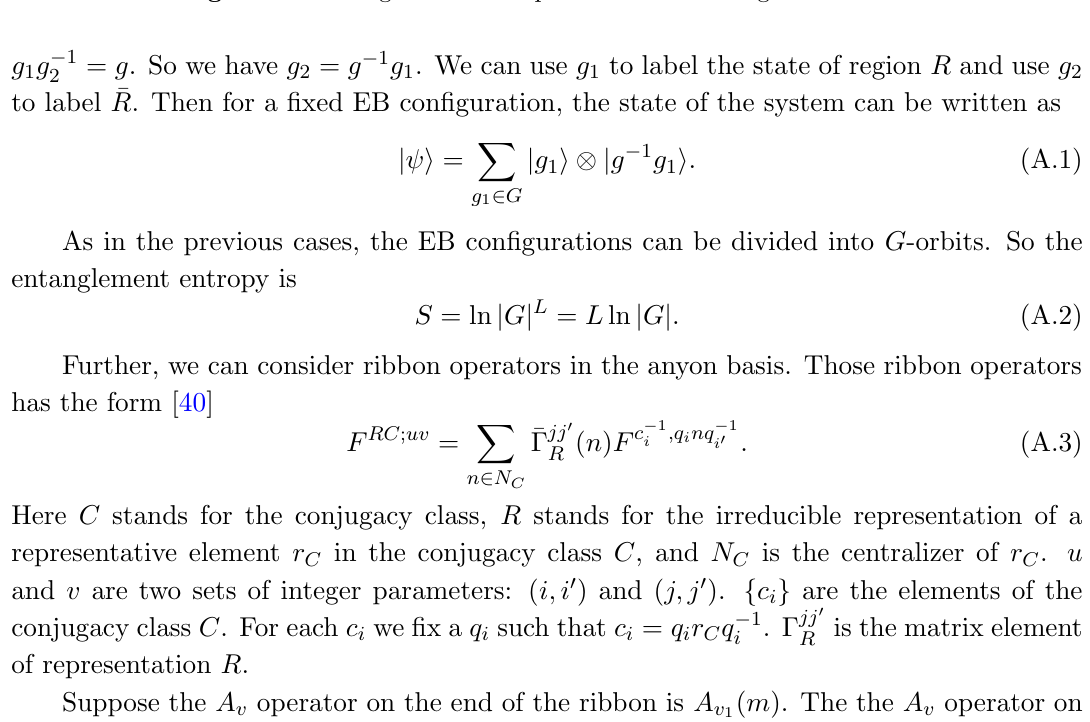
Figure 11 . Acting the ribbon operator F h;g on the ground